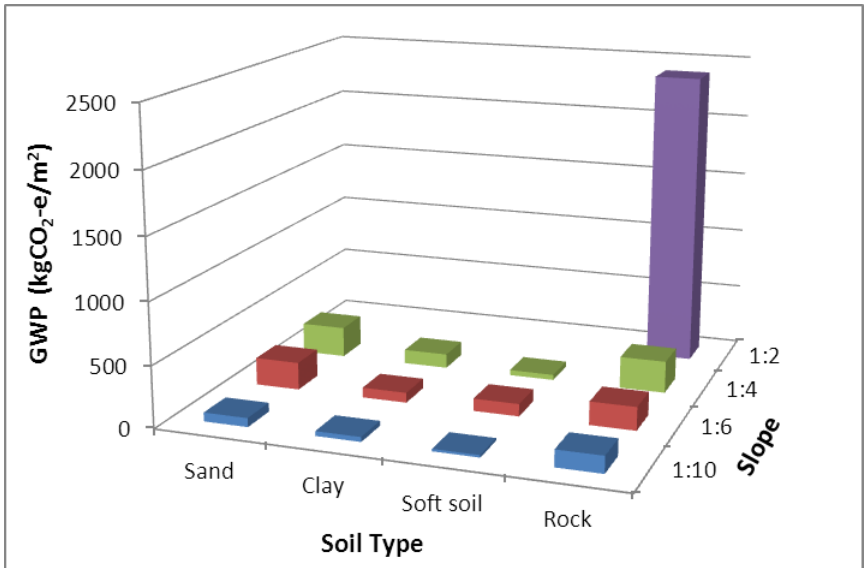
Figure 2: GWP (kgCO /m 2 ) per building footprint by soil and slopes 2-e